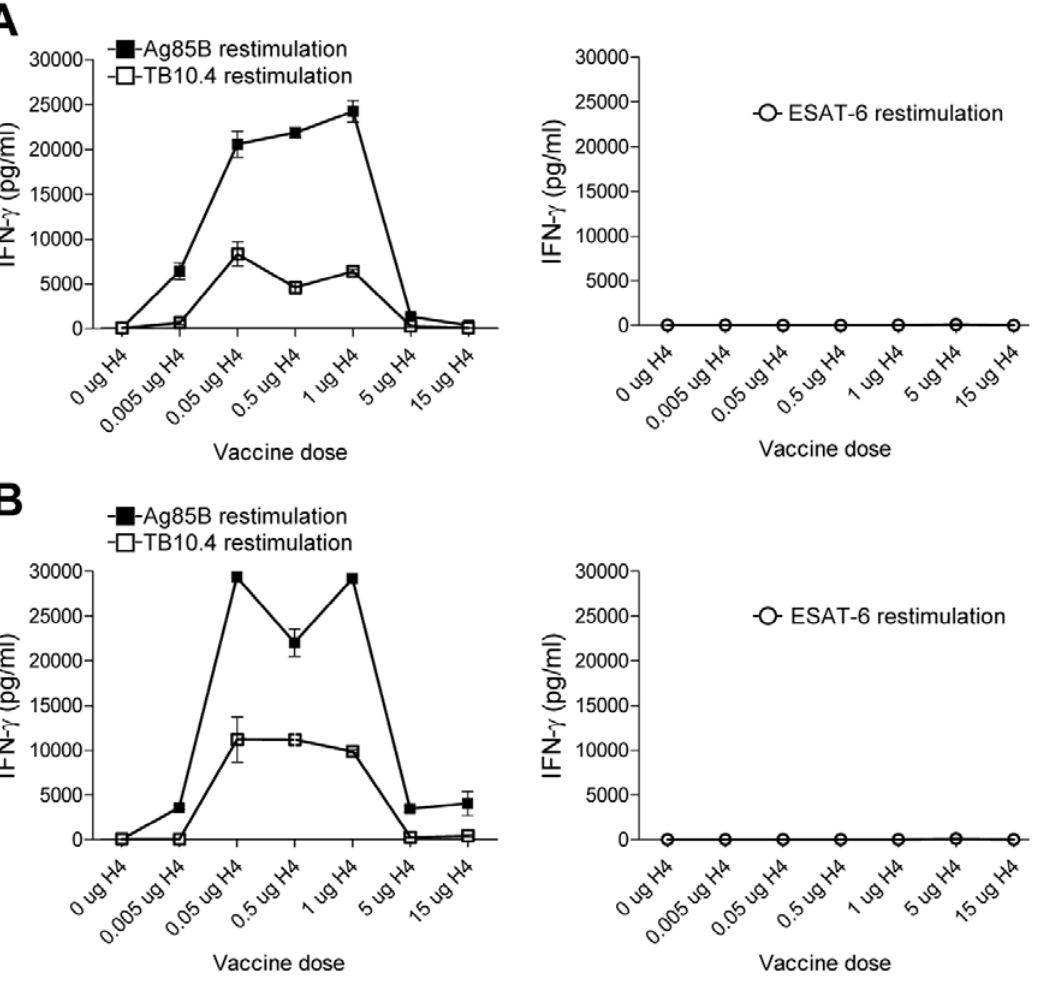
Figure 1. Immune recognition of vaccination antigens. PBMC’s (A) or splenocytes (B) isolated from groups of mice vaccinated with different doses of Ag85B-TB10.4 in IC31 H (and a saline control group) were stimulated with either Ag85B or TB10.4 (or ESAT-6 as negative control). After 72 hours the concentration of cell released IFN- c was determined by ELISA. Five mice per group were pooled. Values represent the means of triplicate and SEM’s are indicated.